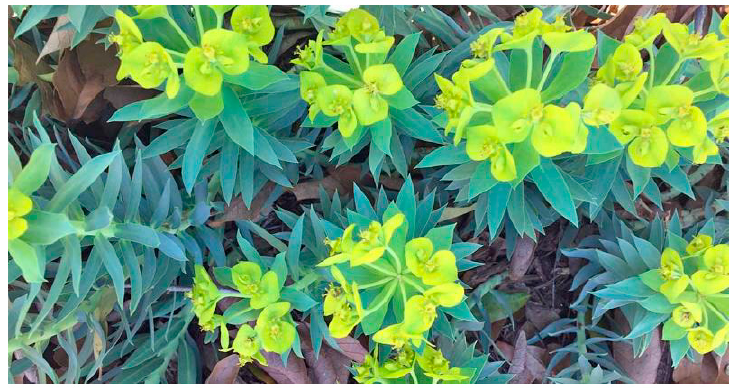
Figure 1. Euphorbiaceae [5].